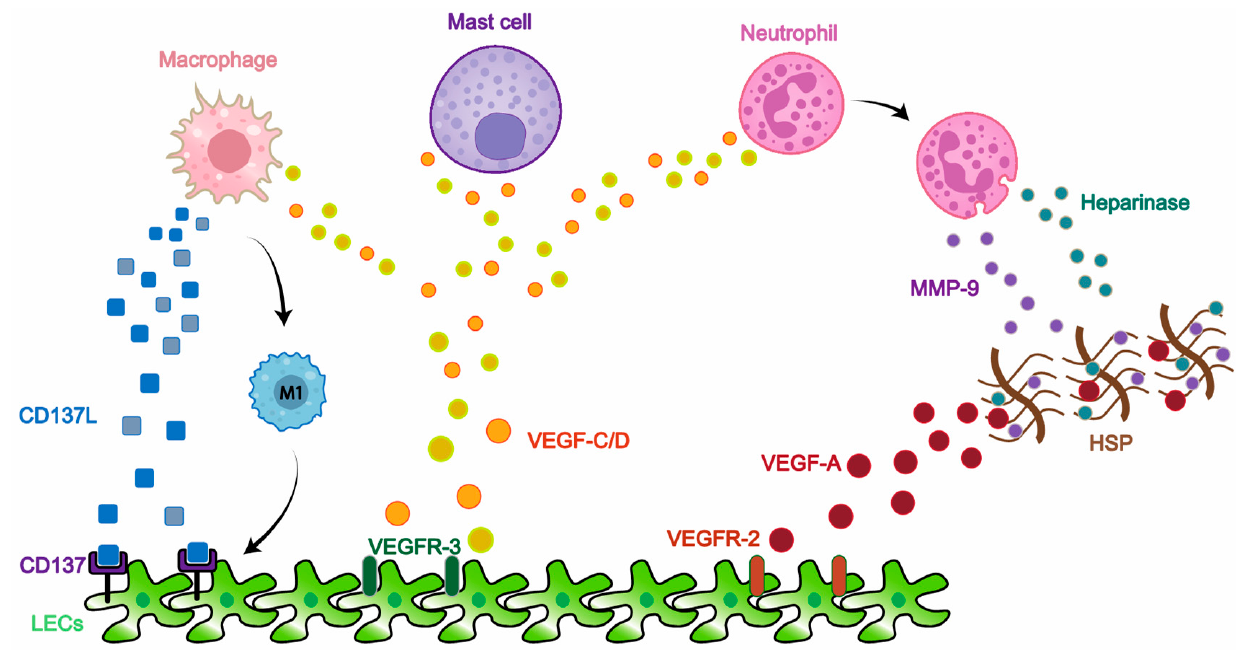
Figure 2. Schematic diagram of immune cells contributing to lymphatic proliferation. Macrophages promote lymphangiogenesis through: ① secreting CD137 ligand to bind with CD137 expressed on LECs; ② differentiating into M1-type macrophages and then into LECs; ③ secreting VEGF-C and VEGF-D in inflammation which binds with VEGFR-3 on LECs. Mast cells promotes lymphatic proliferation through producing VEGF-C and -D. Neutrophils participate the lymphangiogenesis process not only through releasing VEGF-C/D but also secreting MMP-9 and heparinase, which release VEGF-A from HSP and increase the bioactivity of VEGF-A. HSP: heparan sulphate preoteoglycan; LEC: lymphatic endothelial cell; MMP: matrix metalloproteinase; VEGF: vascular endothelial growth factor; VEGFR: vascular endothelial growth factor receptor . Neutrophils are of equal importance. At the site of inflammation, neutrophils in- filtration appeared around lymphatic microvessels before proliferation of the lymphatic network [62]. Similar to macrophages, neutrophils contribute to lymphangiogenesis mainly by secreting molecules in inflammation. Most VEGF-A isoforms bind to extracellular matrix, but only part of secreted VEGF-A has bioactivity [63]. Neutrophil-derived matrix metalloproteinases 9 and heparinase work together to liberate VEGF-A from matrix and raise VEGF-A biological activity, thereby coordinating lymphatic growth [64]. Additionally, neutrophils act as organizers of lymphangiogenesis via releasing VEGF-D, albeit to a lesser extent [64]. Furthermore, neutrophils, cooperating with macrophages, contributed to in- flammatory bowel disease-related lymphangiogenesis by producing VEGF-A, VEGF-C and VEGF-D in zebrafish [65]. Lymph nodes have a similar VEGF-mediated lymphangiogenic pattern to tissues, and neutrophils compensate for the generation of VEGF and thus support lymphangiogenesis in mice lacking B cells